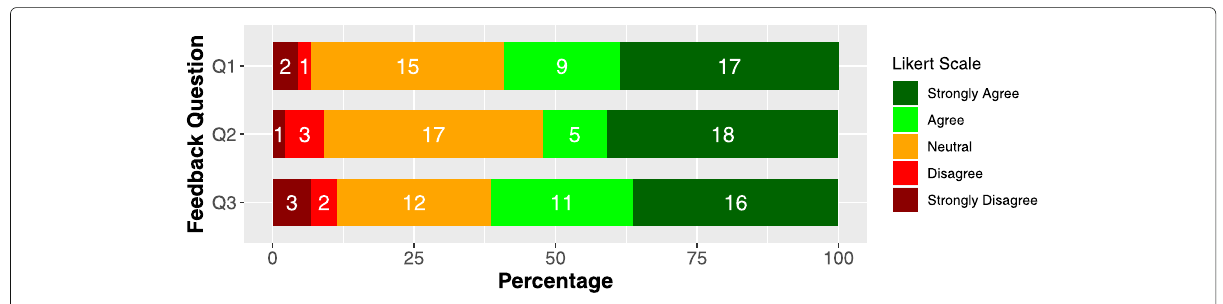
Fig. 11 Evaluation of Challenges in Sifu Platform - Survey S 1 - Overview